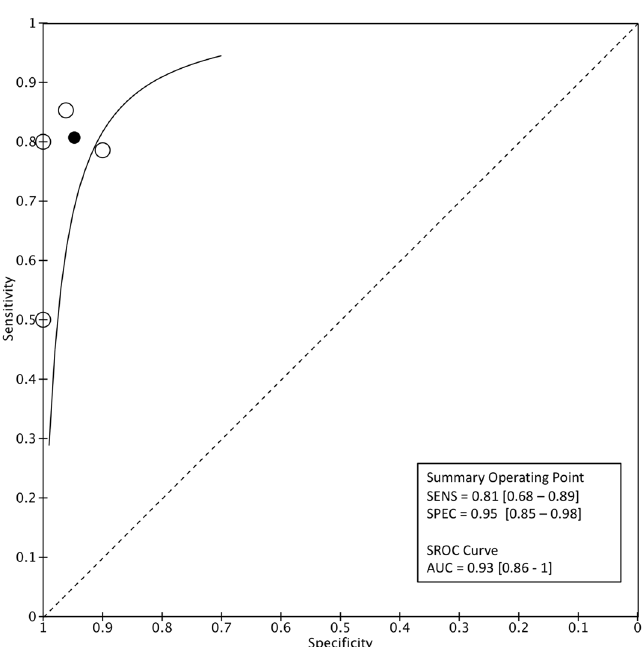
Figure 5. Level-2 classification algorithm for MSA: Summary ROC plot with mean operating sensitivity and specificity